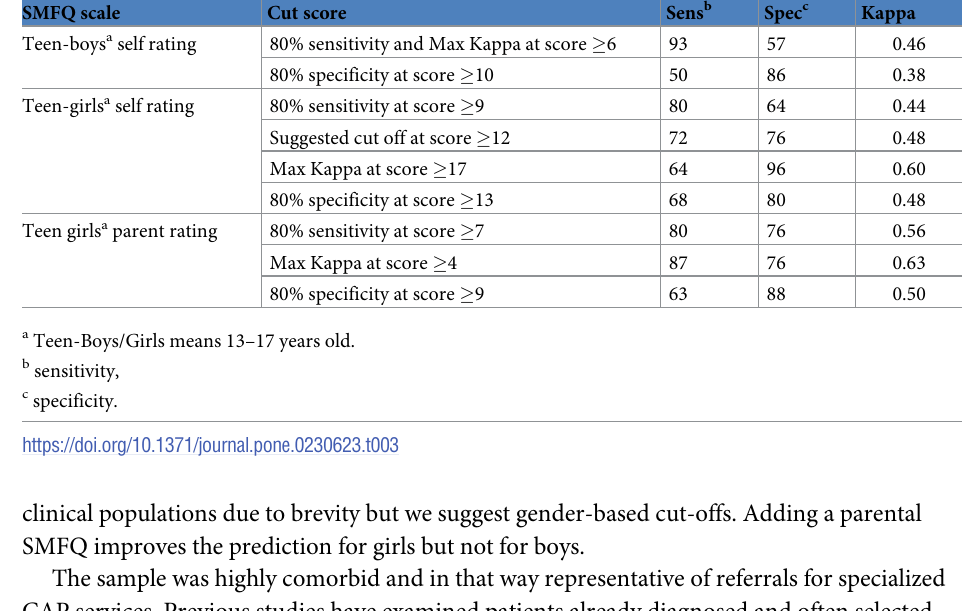
Table 3. Psychometric properties at cut-offs to either prioritize sensitivity, specificity or best separation on the Short Mood and Feelings Questionnaire (SMFQ) for the prediction of depression in